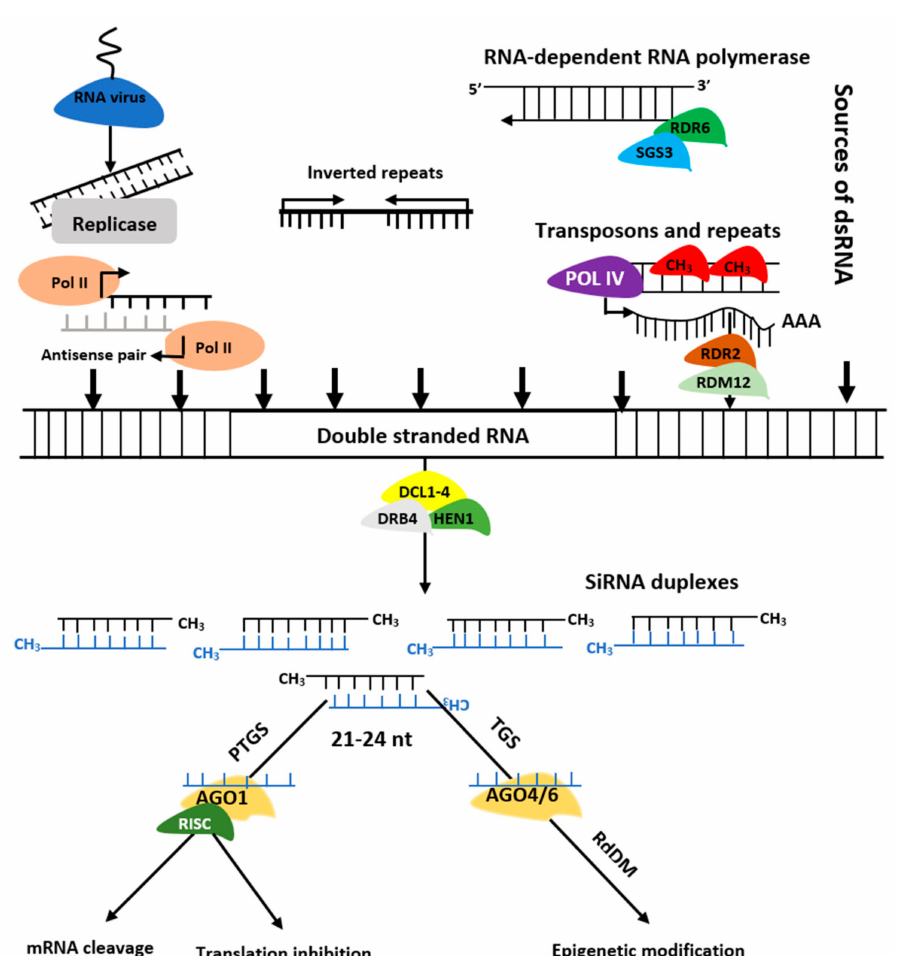
Figure 3. Biogenesis of siRNAs. The double stranded RNA (dsRNAs) is transformed into siRNAs by DCL, HEN1, and DRB. The RISC-AGO complex then guides the selected strands of siRNA duplexes to post transcription gene silencing (PTGS) or transcription gene silencing